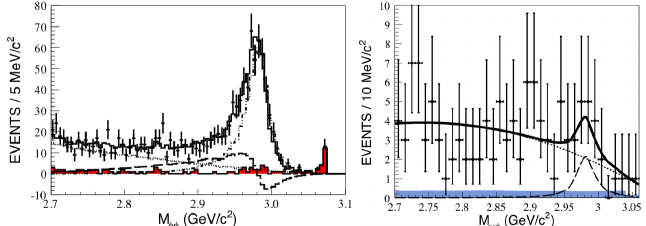
Figure 2. Right is the projection of fit results onto the M ( φφ ) spectrum. The dots with error bars denote the data, the solid line histogram is the overall result, the dot-dashed histogram is the η c signal, the filled red histogram is the combined backgrounds estimated with exclusive MC simulations, the dotted histogram denotes non η c decays, and the long-dash histogram is the interference between the η c and non η c decays. Left is the results of the best fit to the M ( ωφ )